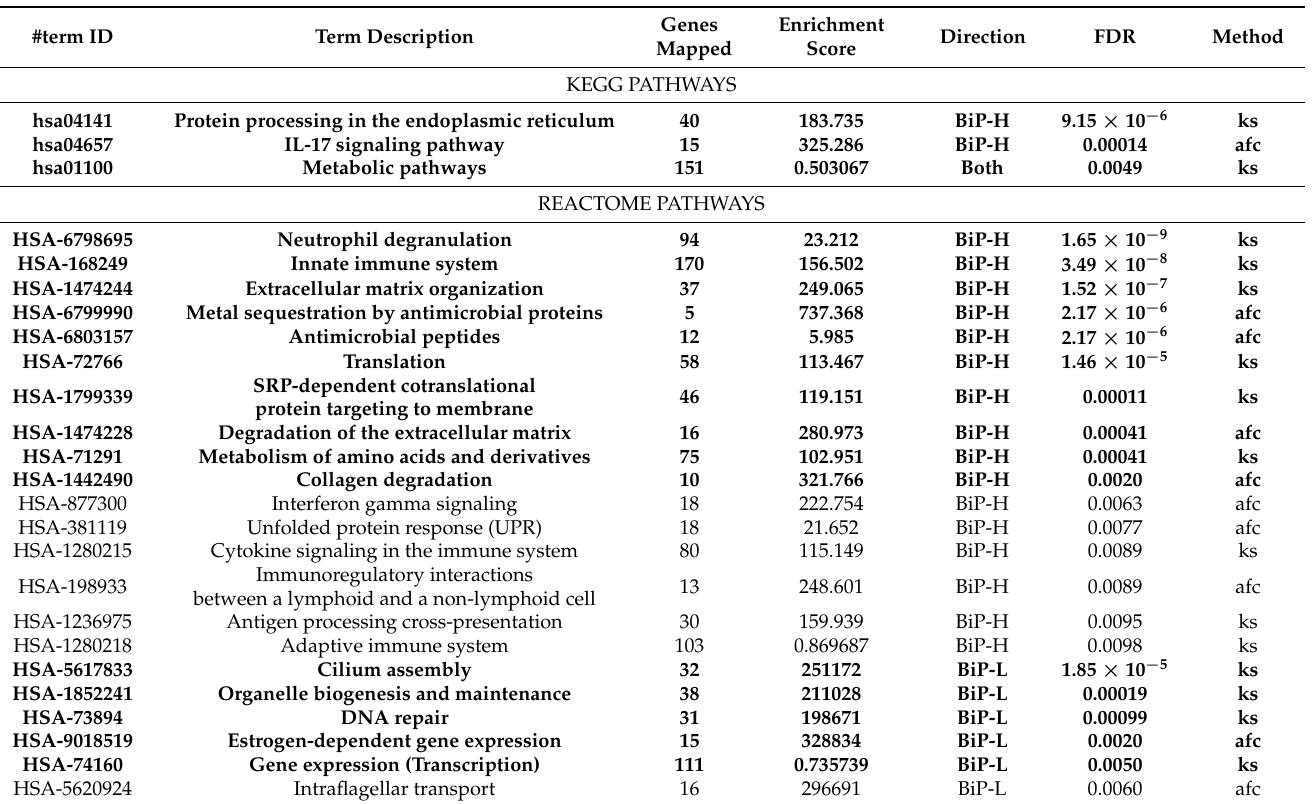
Table 3. Overrepresented pathways in CPTAC protein dataset stratified by BiP-High (BiP-H) and BiP-Low (BiP-L)